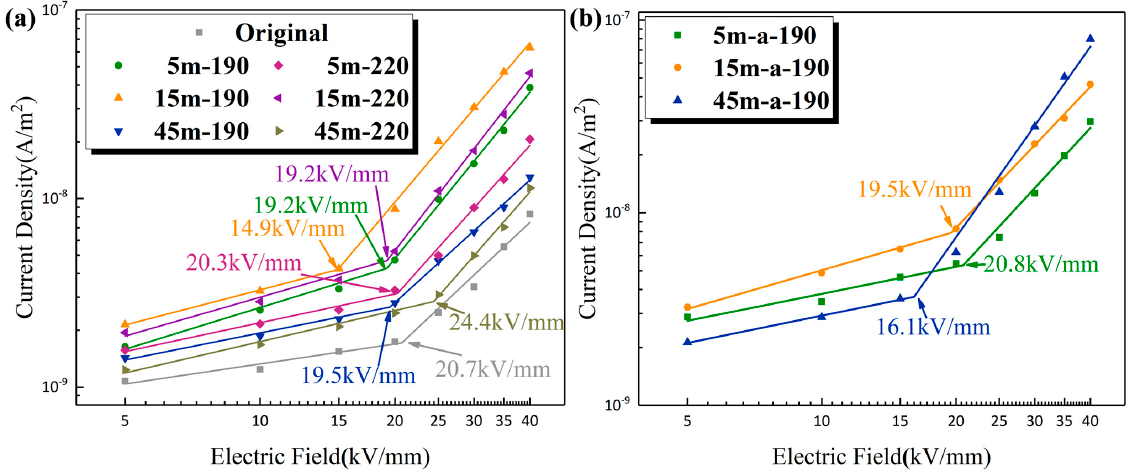
Figure 9. Current density curves changing with field intensity of samples. ( a ): Current density curve without adding antioxidant; ( b ): Current density curve after adding antioxidant. According to the test results, the variation of current density was essentially con- sistent with the variation trend of the characteristics of space charge accumulation. The unsheared material had a lower current density and a higher nonlinear threshold field strength, reducing the likelihood of space charge accumulation in the material. During the initial stage of shearing, the molecular chains were ordered along the shear field’s direc- tion. The gradual disentanglement of the molecular chains resulted in greater spacing be- tween them, increased carrier mobility, and consequently a higher current density. Under the influence of a specific electric field, shearing for 15 min destroyed the regularity of the material’s molecular chains, reduced crystallinity, expanded the free volume, and in- creased the number of carrier transport channels, so that the current density continued to increase. Concurrently, the accumulation of space charge decreased the nonlinear thresh- old field strength. Due to oxidative degradation, the material sheared for 45 min produced a large number of carbonyl groups, and the carbonyl polar groups introduced a large number of deep traps into the material. The carriers were captured by the traps during the migration process, which decreased the carrier concentration and inhibited the carrier migration, resulting in a significant decrease in conduction current. As the accumulation of space charge decreased, the current density curve entered the current-limiting region for space charge when the field strength increased. After increasing the shear temperature, the sample crystallinity improved. Thus, the free volume decreased, the potential barrier for carrier migration increased, thereby impeding carrier migration to some degree, the current density decreased, and the nonlinear threshold field strength shifted to higher fields. The addition of antioxidants facilitated heterogeneous nucleation in PP sheared for 5 and 15 min. The increase in the number of material grains led to an increase in the number of crystal interfaces, which enhanced the ability to trap charges at the interfaces and in- hibited the migration of carriers, resulting in a shift of the nonlinear threshold field strength to higher fields. The addition of antioxidant to the sample sheared for 45 min decreased the threshold field strength compared to that before the addition of antioxidant. This is likely to be because the antioxidant introduced more impurity ions during the long shear time, which resulted in a slight increase in current density and a shift of the nonlin- ear threshold field strength to a lower field.